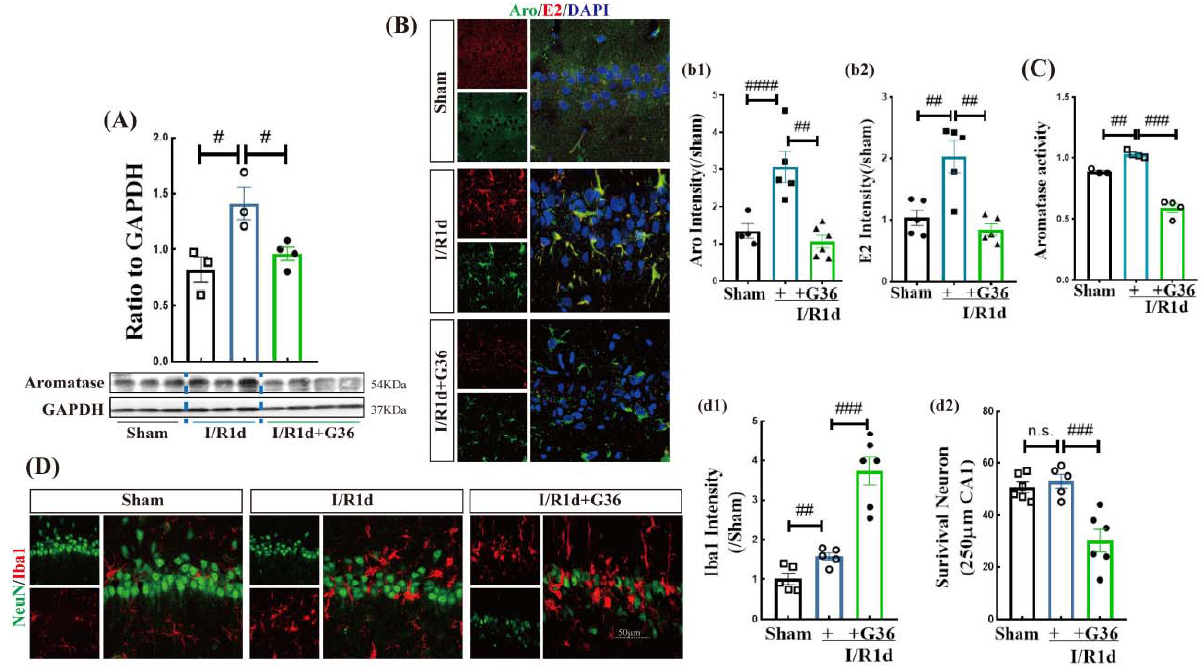
Figure 4. GPER was required for the neuroprotective effect of Aromatase-BDE2 signaling in the ovariectomized rat hippocampal CA1 region after GCI. ( A ) Western blot analysis was used to detect changes in aromatase in the sham, one day of reperfusion (I/R1d), and I/R1d + G36 treatment groups. ( C ) Effect of G36 on Aro activity, as determined using an enzyme-linked immunosorbent assay (ELISA). Representative photographs of double immunofluorescence staining of ( B ) Aro (green) and E2 (red), and ( D ) NeuN (green) and Iba1 (red) in the indicated groups are shown. DAPI (blue) was used to stain the nuclei. A quantitative analysis of the fluorescence intensity ratio of Aro ( b1 ), E2 ( b2 ), and Iba1 ( d1 ) to the sham group is shown. ( d2 ) Quantification was performed by counting the number of NeuN-positive neurons per 250 µ m segment in the medial CA1 pyramidal cell layer. ( n = 3–6 per group). # p < 0.05, ## p < 0.01, and ### p < 0.001. and #### p < 0.0001, n.s., no significance. Scale bar, 50 µ m. Magnification, 40 × . GPER, G-protein-coupled estrogen receptor 1; BDE2, brain-derived estrogen; Aro, Aromatase; E2, 17 β -estradiol; Iba1, Ionized calcium binding adaptor molecule